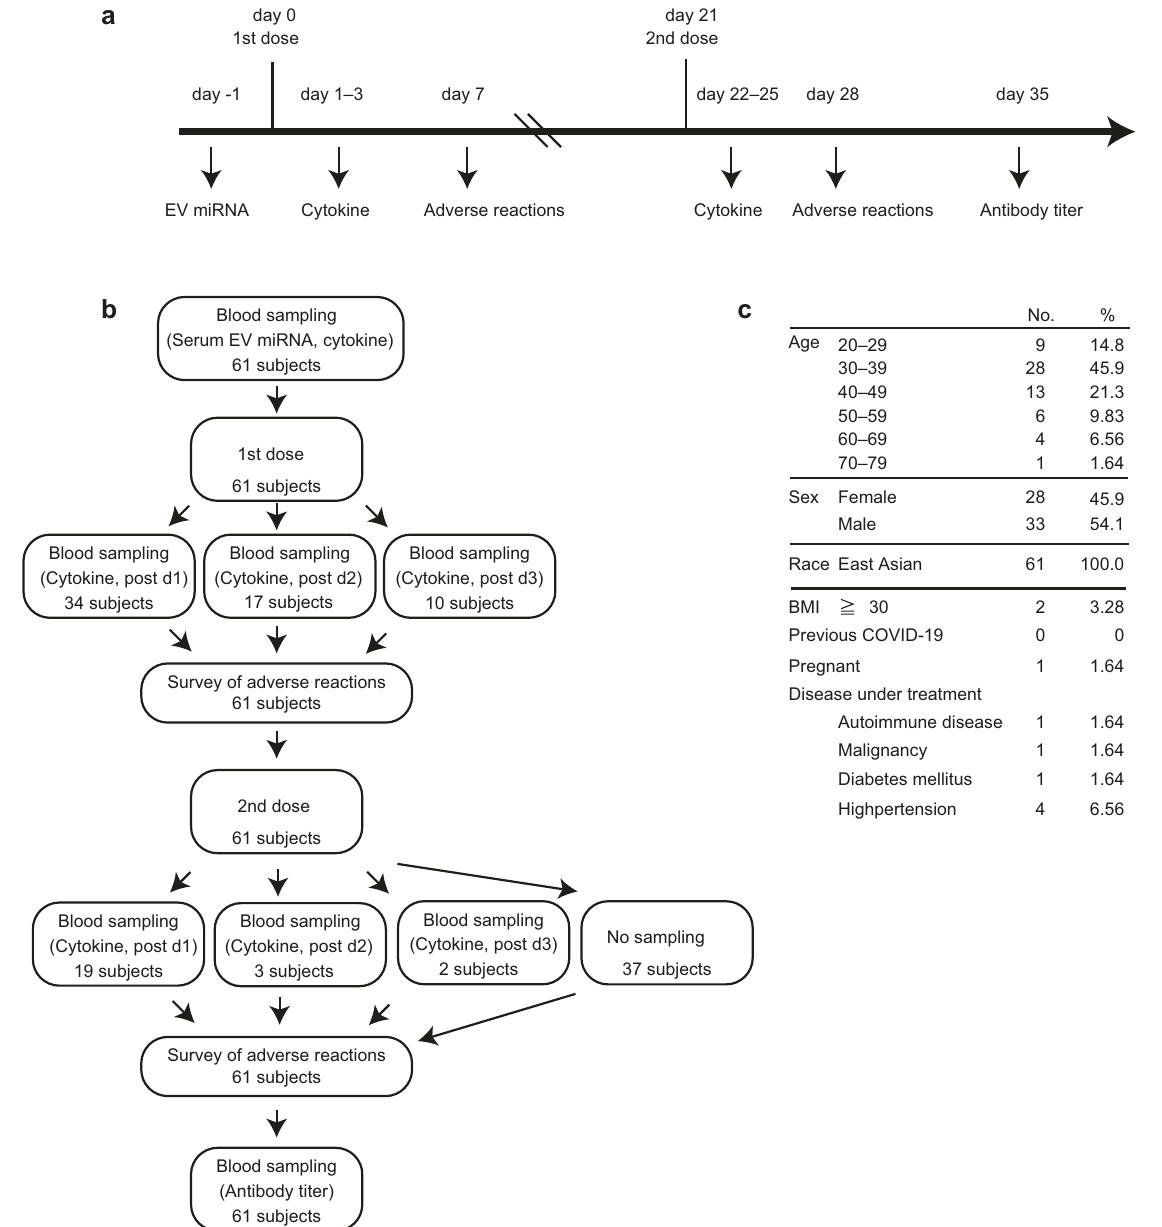
Fig. 1 Enrollment and demographic characteristics of the participants. a Schematic of the schedule of sampling and vaccination. b The diagram represents all enrolled participants. The numbers of subjects at the indicated vaccination or sampling steps are shown. c Demographic characteristics of all